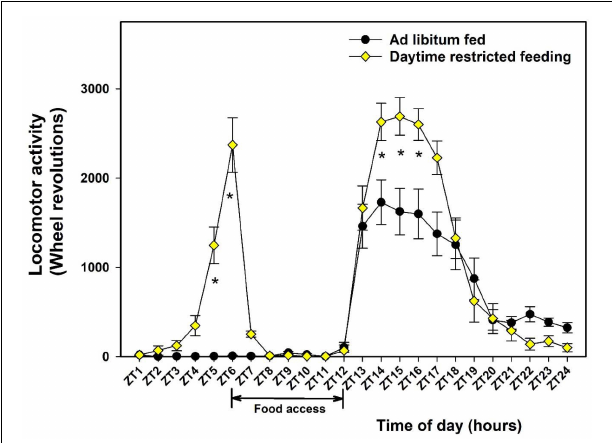
FIGURE 1 | Daily profiles of wheel-running activity in control mice fed ad libitum (closed circles) or exposed to daytime restricted feeding (yellow diamonds). During daytime restricted feeding, food was available between Zeitgeber (ZT) 6 to ZT12 (see section “Materials and Methods”). For each individual, data were averaged during the last 7 days of recording before the day of sampling. During the analyzed period, control mice were fed ad libitum . * P < 0.05 between feeding conditions for a given ZT after post hoc Tukey comparison and two-way ANOVA with repeated